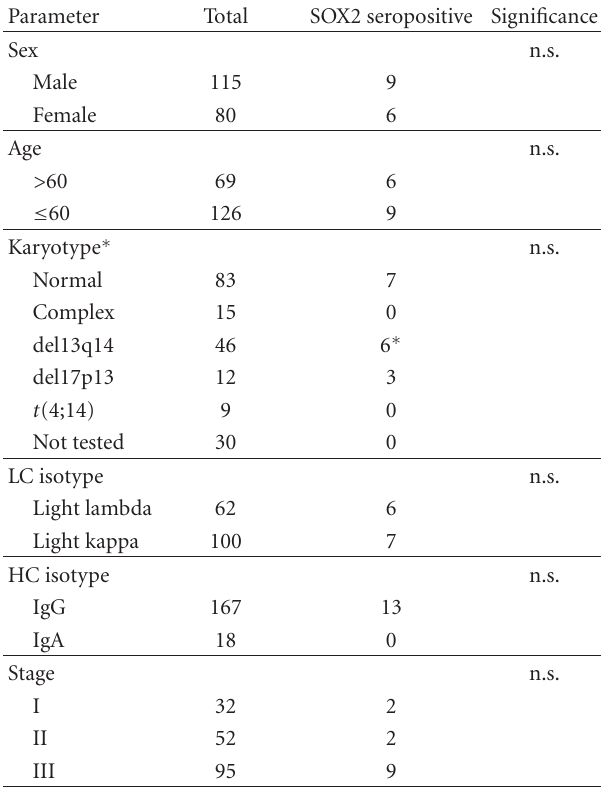
Table 1: Patient characteristics. Data are shown for all patients and for the subgroup of SOX2-seropositive patients. LC: light chain; HC: heavy